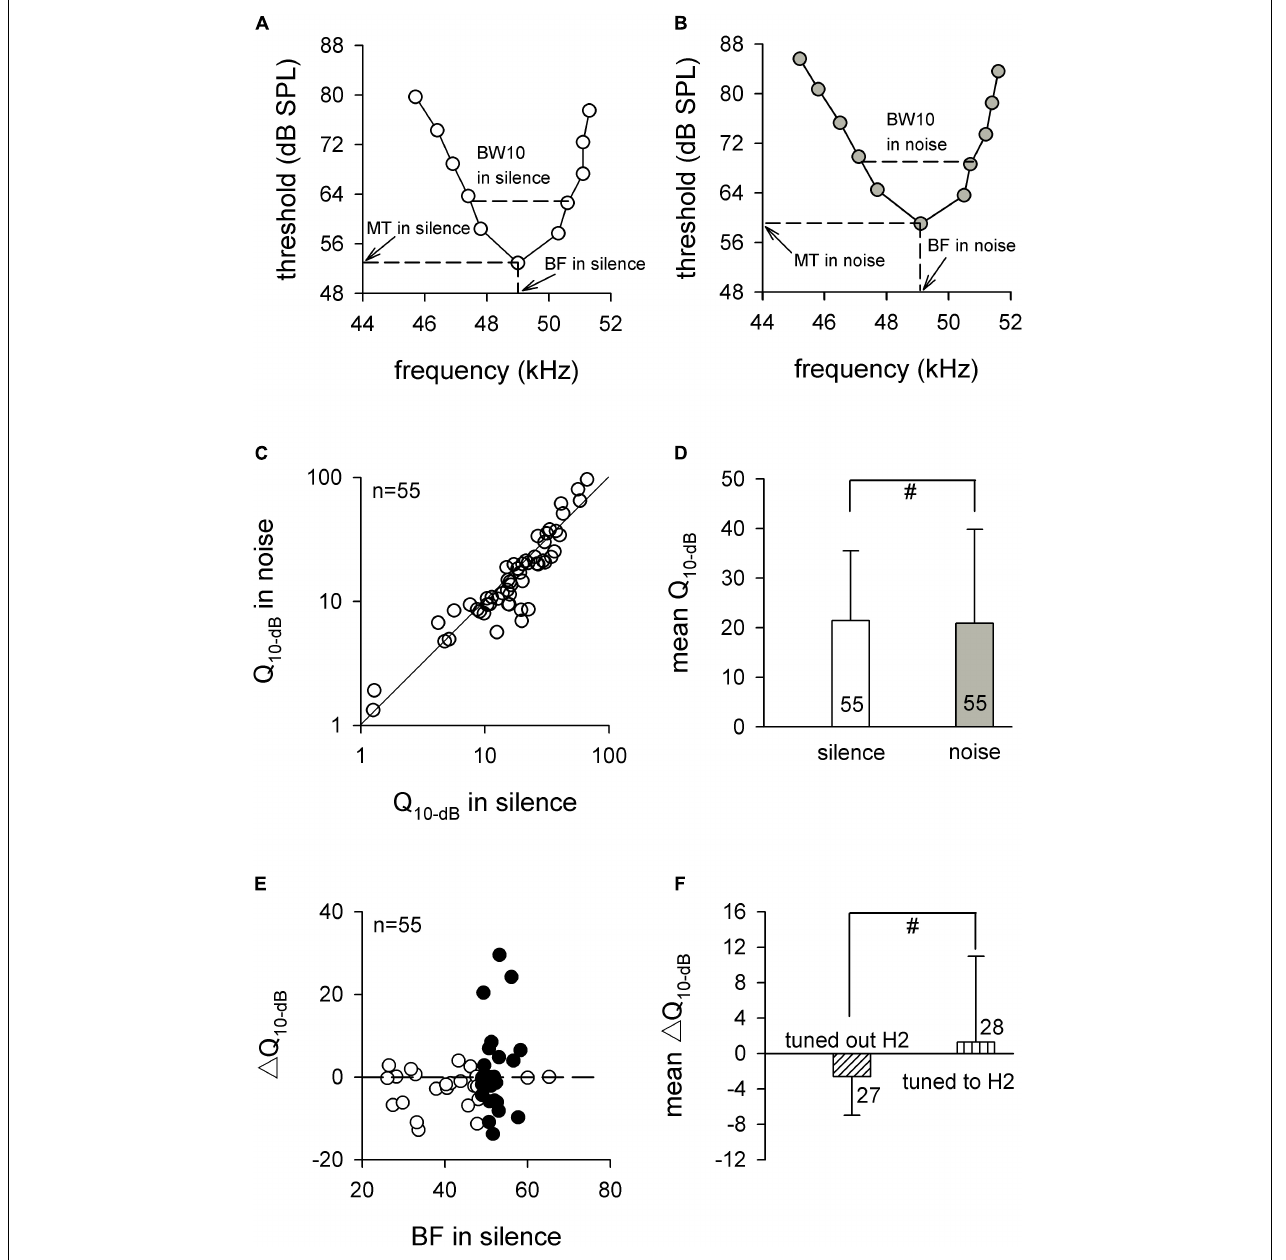
FIGURE 4 | The frequency sensitivities of auditory midbrain neurons in silence and noise conditions. (A,B) A representative frequency tuning curve for auditory midbrain neurons in silence (A) and noise (B) conditions. The dashed line shows the method for obtaining BF, MT, and BW10. (C) The distribution of Q 10 dB in noise condition compared with Q 10 dB in silence. The solid line is the line of equality. (D) Comparison of the mean Q 10 dB between silence and noise conditions. (E) The distribution of (cid:49) Q 10 dB against BF in silence. The horizontal dashed line is the zero line. Filled circle, neurons tuned to H2; unfilled circle, neurons tuned out H2. (F) Comparison of the mean (cid:49) Q 10 dB between neurons that tuned out H2 and neurons that tuned to H2. BF, best frequency. MT, minimal threshold. BW, bandwidth. # p >